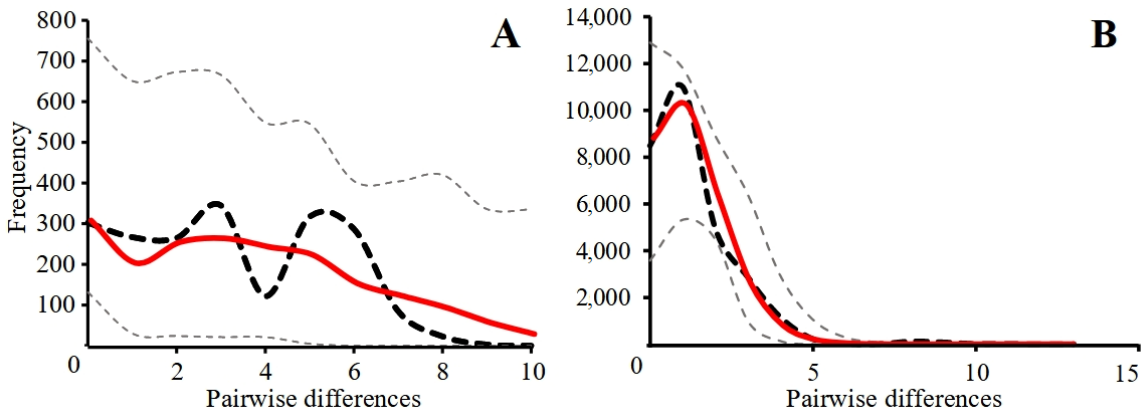
Figure 3. Mismatch distributions of A. anatina samples based on the mitochondrial COI gene: ( A ) mismatch distribution of the EUR1 sub-lineage; test of goodness-of-fit: sum of squared deviation = 0.015; p (Sim. SSD >= Obs. SSD) = 0.440; Harpending’s raggedness index = 0.035; p (Sim. Rag. >= Obs. Rag.) = 0.620; ( B ) mismatch distribution of the EUR2 sub-lineage; test of goodness-of-fit: sum of squared deviation: 0.003; p (Sim. SSD >= Obs. SSD) = 0.150; Harpending’s raggedness index = 0.061, p (Sim. Rag. >= Obs. Rag.) = 0.360. Bold dashed black lines indicate observed distribution, and solid red lines represent simulated distribution under a spatial expansion model. Dashed lines represent lower and upper confidence intervals ( p < 0.01).